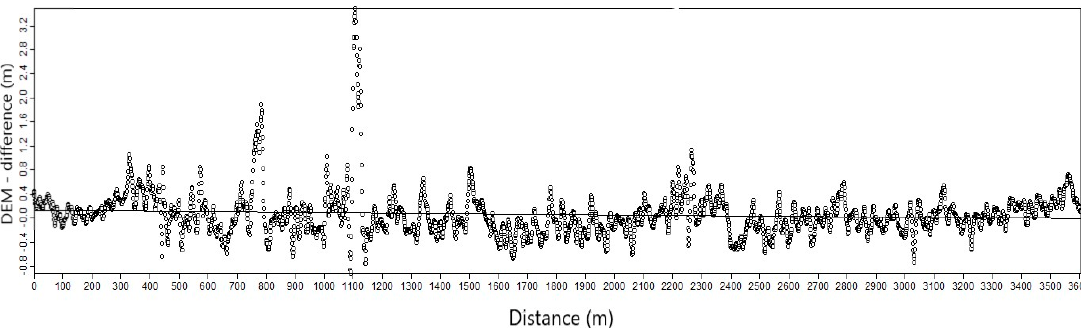
Figure 8. Profile 1, located west of the tongue of Ngozumpa glacier. The profile shows the surface differences in off-glacier terrain between the spring 2015 and autumn 2015 acquisitions from south to north.